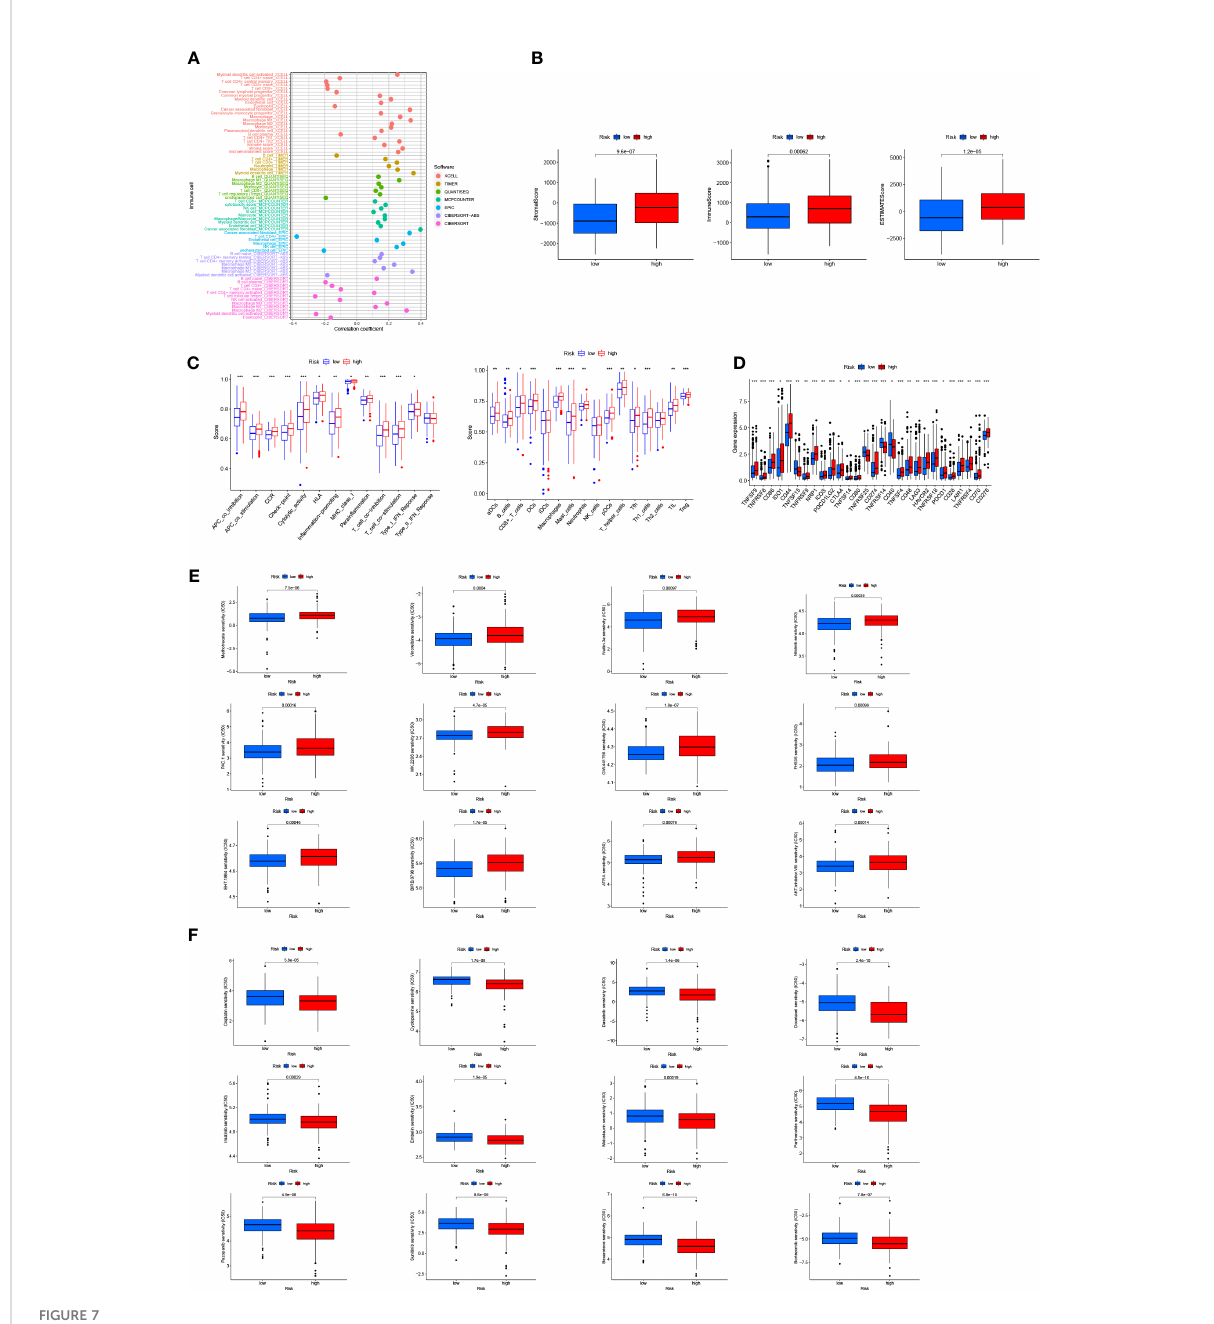
FIGURE 7 Discussion on immune in fi ltration and immunotherapy for patients with bladder cancer: (A) Bubble chart for immune cell correlation analysis; (B) Differences in immune microenvironment scores of patients at high and low risks; (C) Boxplots of immune cells in high- and low-risk groups and immune-related pathway analysis; (D) Analysis of immune checkpoints of the two risk groups; (E, F) Analysis of patients ’ sensitivity to drugs. ***p < 0.001, **p < 0.01, *p <